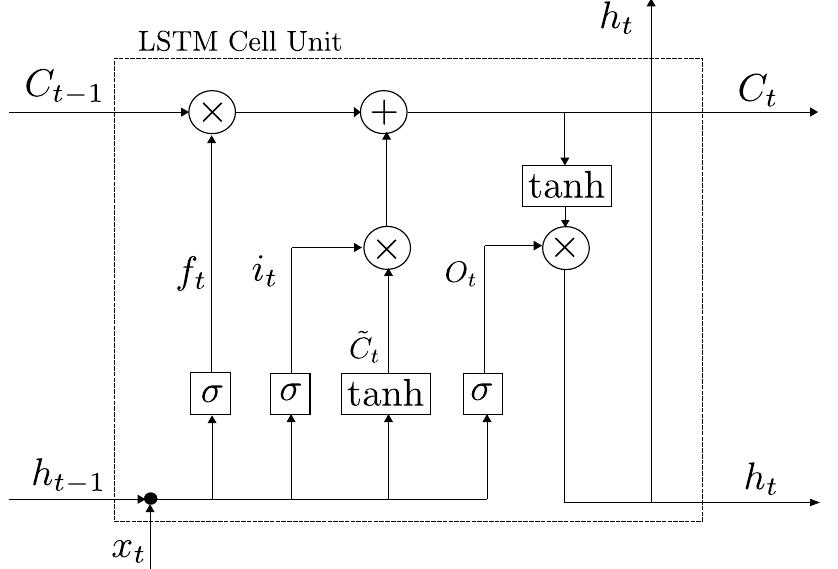
Figure 5. A basic diagram of the LSTM unit. Note that it is known to be the general struc- ture of modern LSTM unit, and the similar and identical LSTM units are referred to in various literature